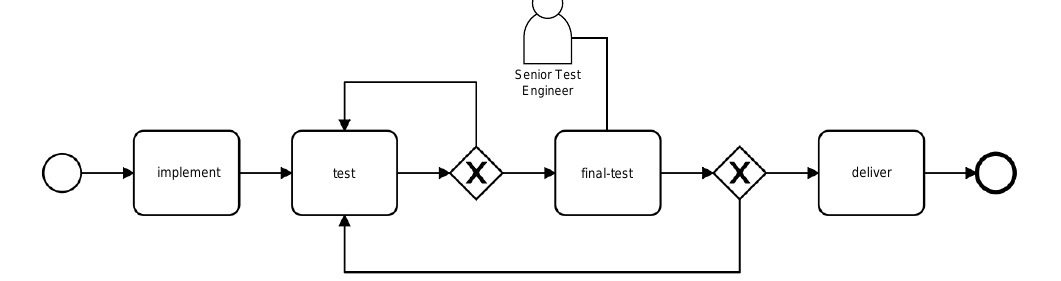
Figure 2. (Imperative) Process Model with complex requirement.